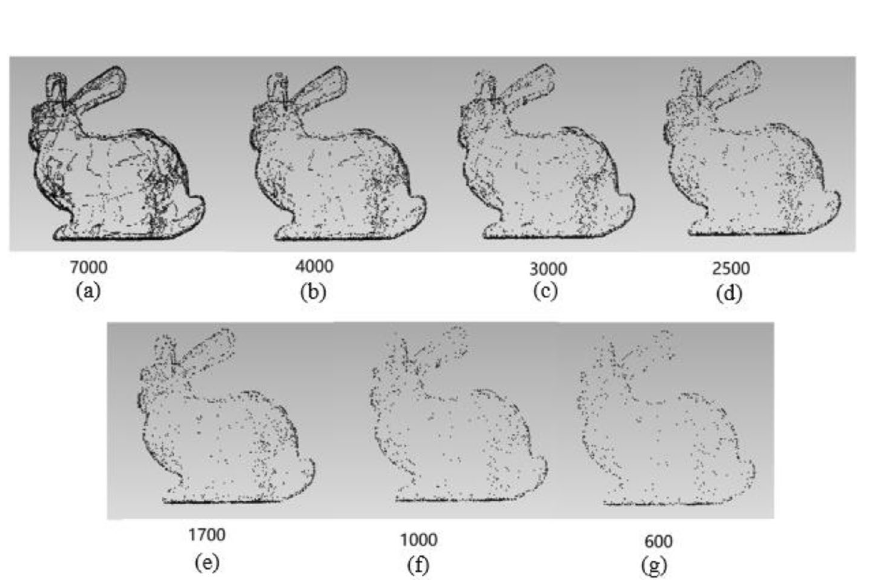
Figure 10. The feature extraction results with different